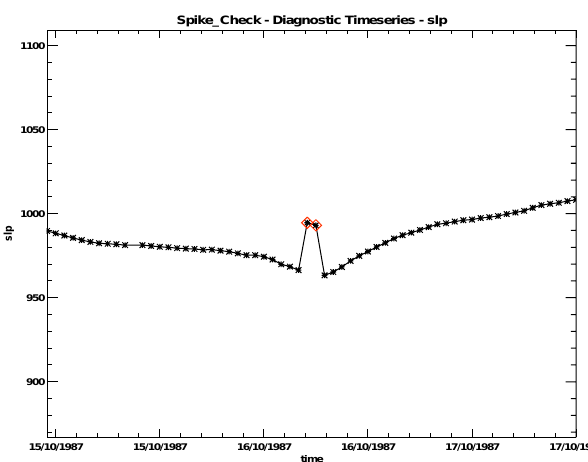
Fig. 16. Sea level pressure data from station 032450-99999 (New- castle Weather Centre, 54.967 ◦ N, − 1.617 ◦ W, 47m) during mid- October 1987. The two observations that have triggered the spike check are clearly visible and are distinct from the rest of the data. Given their values (994.6 and 993.1hPa), the two flagged obser- vations are clearly separate from their adjacent ones (966.4 and 963.3hPa). It is possible that a keying error in the SYNOP report led to 946 and 931 being reported, rather than 646 and 631. How- ever, we make no attempt in this dataset to rescue flagged